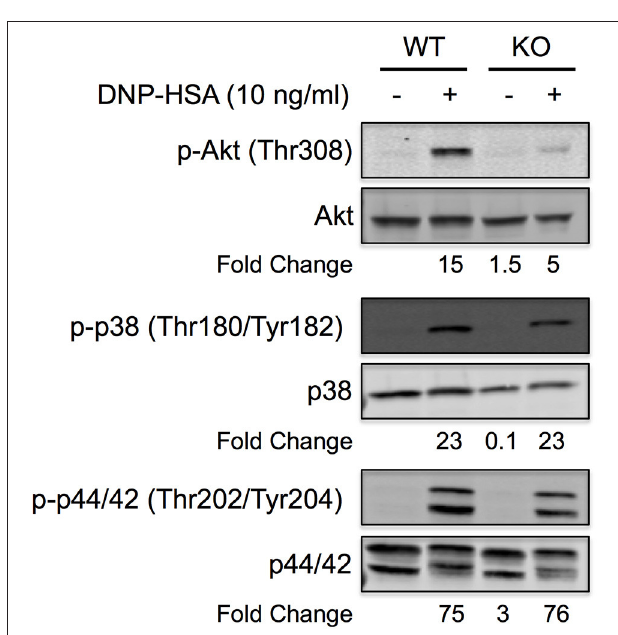
FIGURE 7 | Fc ε RI-induced Akt phosphorylation is specifically inhibited in miR-155 KO BMMCs. Representative Quantitative Western blot showing phosphorylation status of Akt, p38, and p44/42 in wild-type and miR-155 KO BMMCs following Fc ε RI crosslinking with multivalent antigen. IgE-sensitized BMMCs were activated for 5min with NP-BSA (10ng/ml) and whole cell lysates were separated by reducing SDS-PAGE. Total and phosphorylated proteins were analyzed on the same blot by 2-color (680 and 800nm) multiplexing on a near-infrared detection system. Blot is representative of at least three independent experiments with different BMMC cultures from different mice. Fold change in phosphorylation was calculated relative to non-activated wild-type